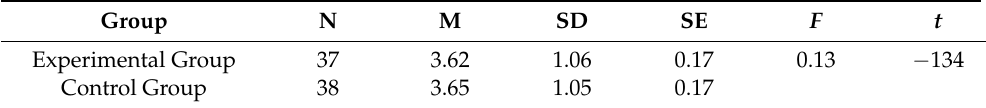
Table 4. The independent t -test analysis of learning satisfaction.